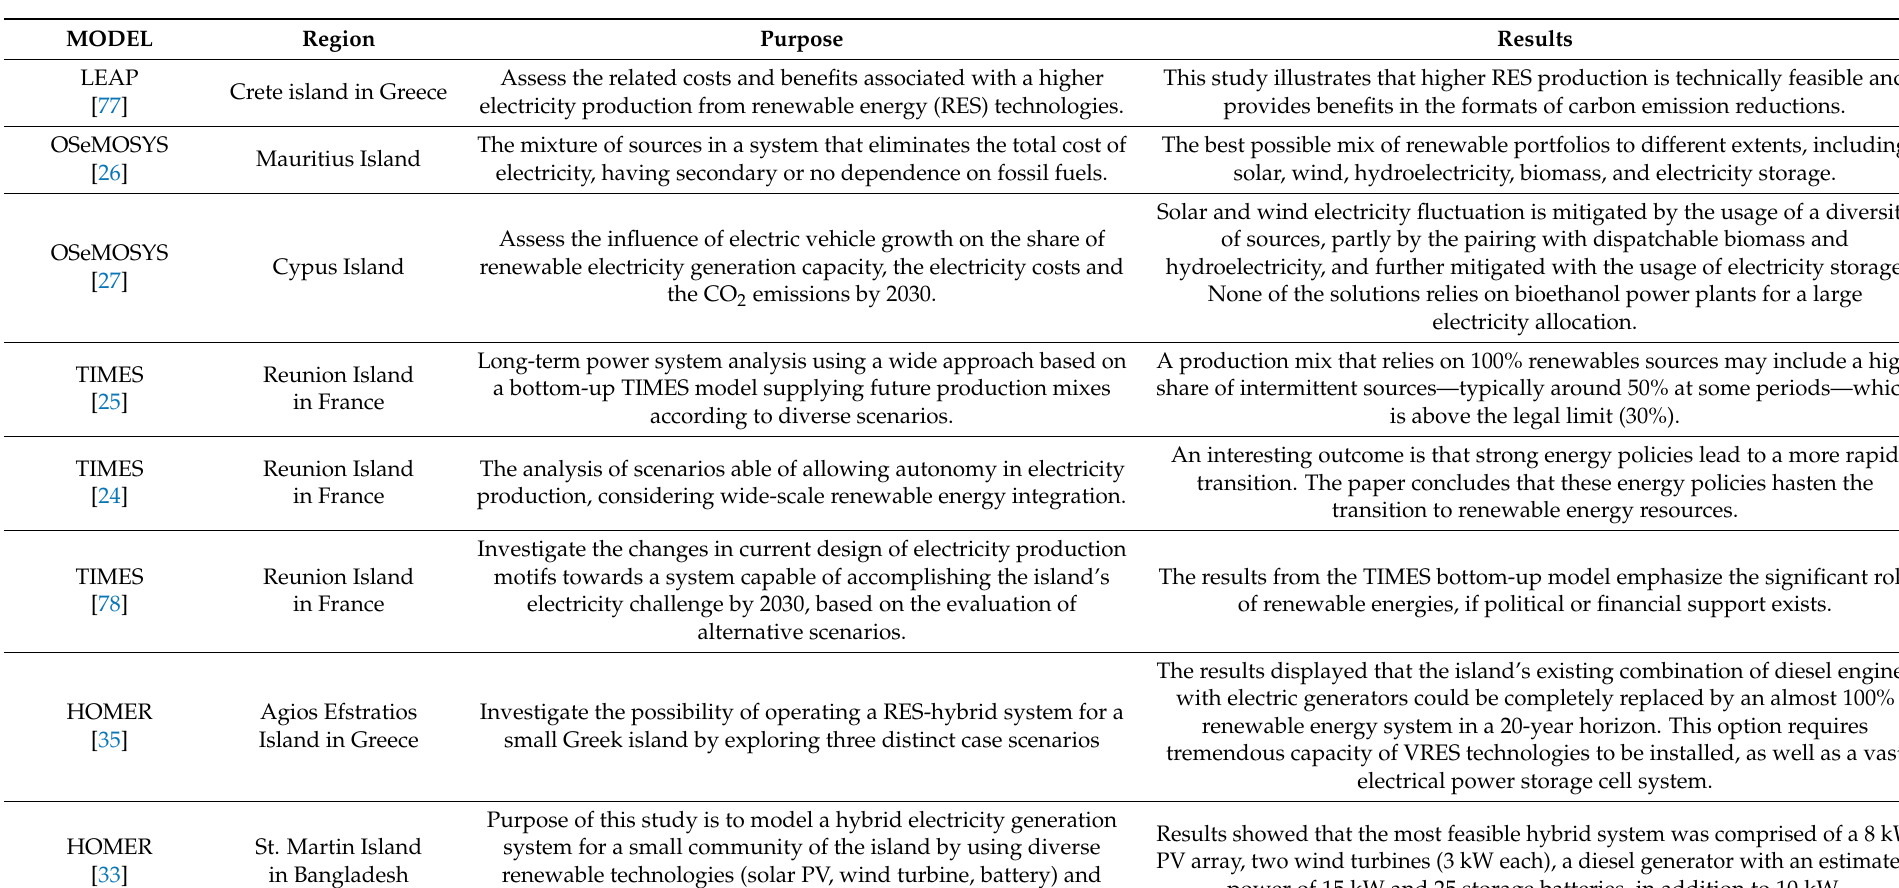
Table A1. Previous case studies on non-interconnected